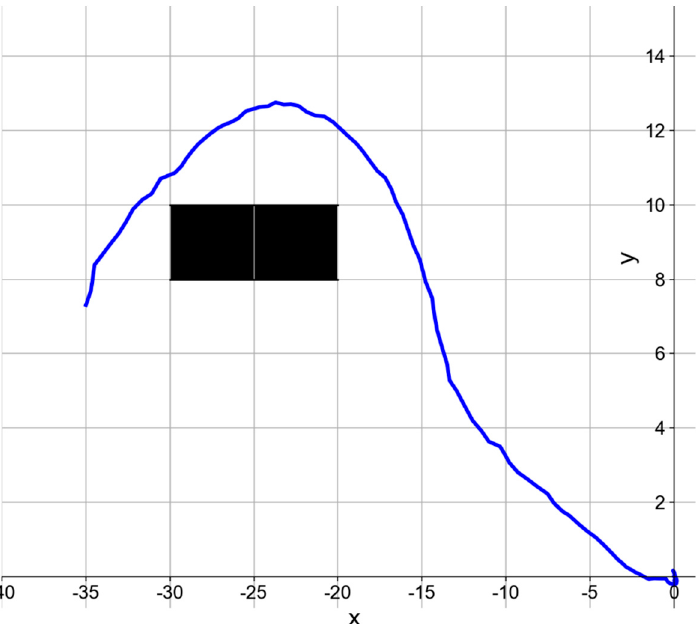
Figure 18. The trajectory of AUV in the fishing net avoidance experiment. The blue line rep-resents the navigation trajectory of the AUV, and the grid filled with black represents the position of the fishing net.